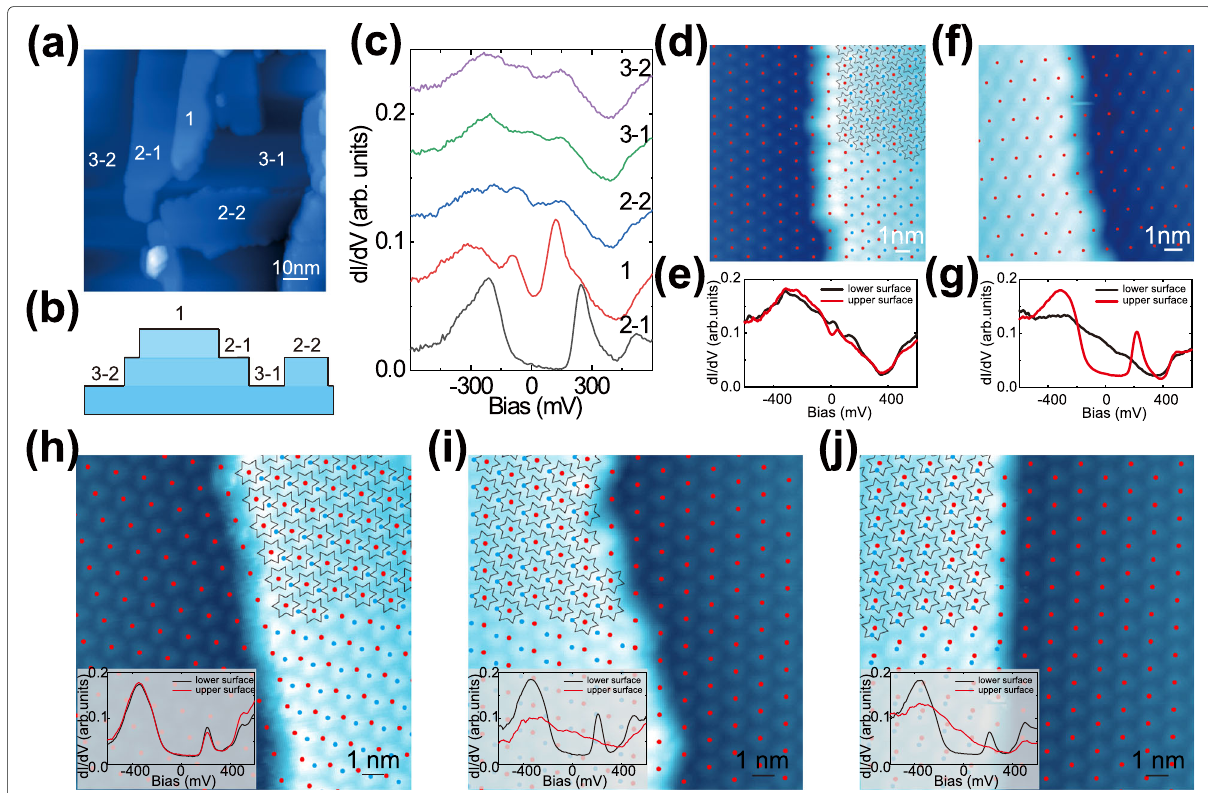
Fig. 6 Stacking order effect in 1 T -TaSe 2 . a A 100 × 100 nm 2 topography in bulk 1 T -TaSe 2 , with a schematic side view shown in b . c Typical dI / dV spectra on different regions in a . d – g The stacking orders and corresponding dI / dV spectra with a lower-layer metallic spectrum. The SD centers in the upper layer are aligned with the d SD outer-corner sites (AC-stacking order), and f center sites (AA-stacking order) in the lower layer. h - j The stacking orders and corresponding dI / dV spectra with a lower-layer insulating spectrum. The corresponding stacking orders are h AC, i AC’, j AB. Taken from ref.